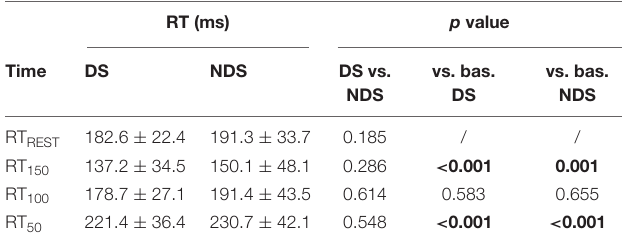
TABLE 1 | Reaction time (RT) at rest and after transcranial magnetic stimulation (TMS). RT (ms)